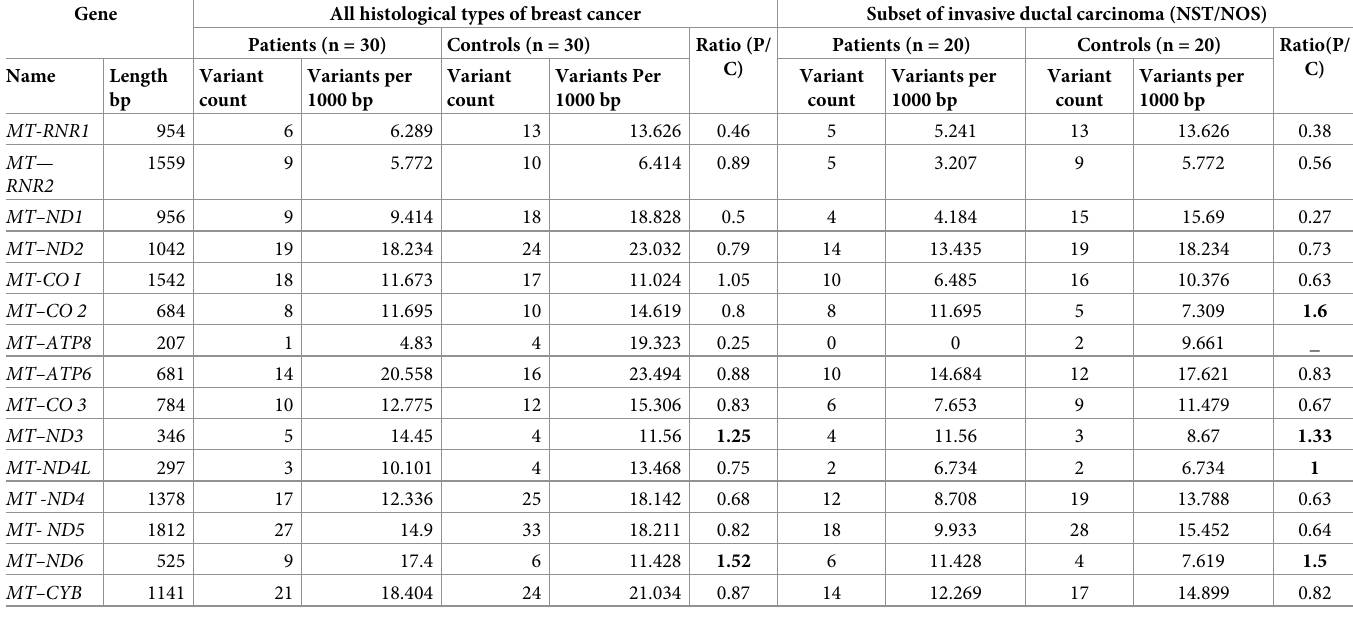
Table 3. Mutation rates of different genes in the patients and the controls subjected to next generation sequencing. Gene All histological types of breast cancer Subset of invasive ductal carcinoma